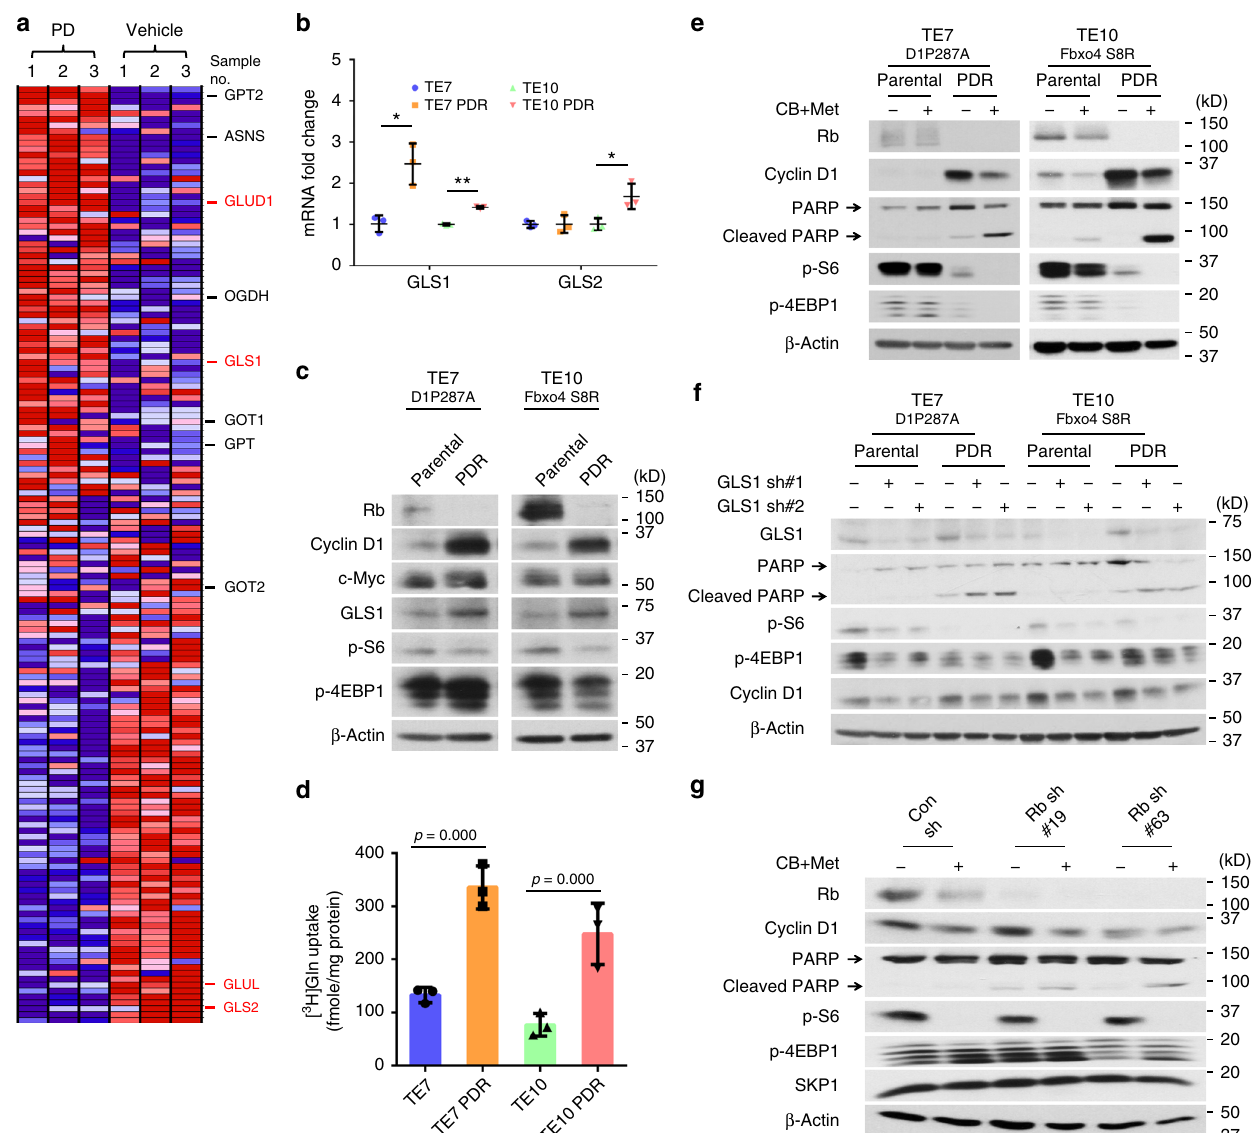
Fig. 7 Combined treatment overcomes CDK4/6 inhibitor resistance in esophageal squamous cell carcinoma (ESCC) cells. a Blue-Pink O ’ Gram in the Space of the Analyzed Gene Set with NCBI GEO (GSE40513), the comparison of Gln metabolism genes between palbociclib and vehicle-treated mouse breast cancer V720 cells. Glutamate-ammonia ligase (GLUL), glutamate dehydrogenase (GLUD), asparagine synthetase (ASNS), glutamic-oxaloacetic transaminase (GOT), and glutamic-pyruvic transaminase (GPT). Red color indicates gene upregulation; blue color indicates gene downregulation. b The expression of GLS1 and GLS2 mRNAs in parental and PDR cells. Data represent as mean ± s.d., two-tailed Student t- test was used to compare means ( n = 3). * p < 0.05, ** p < 0.01. c Western blot analysis of GLS1 levels in parental and PDR cells. d PDR ESCC cells exhibit increased [ 3 H]Gln uptake relative to parental counterparts (1 × 10 5 cells used). Data represent as mean ± s.d., one-way ANOVA was used to compare means with Bonferroni as Post Hoc test ( n = 3); p- values are listed. e CB-839 plus metformin treatment for 24 h induces more apoptosis in both TE7PDR and TE10PDR cells. f GLS1 knockdown increases apoptosis in both TE7PDR and TE10PDR cells. g Rb knockdown induces cell apoptosis in TE15 cells upon combined treatment for 24 h.